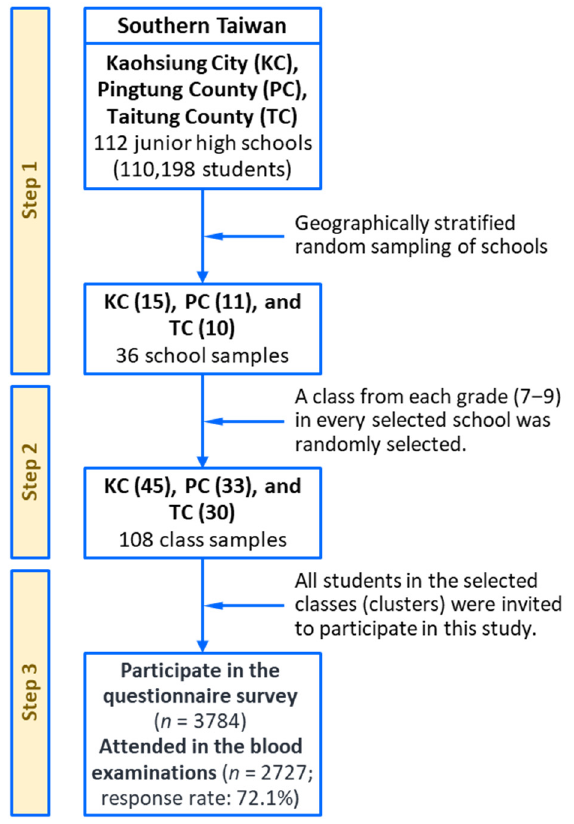
Figure 1. A multistage, geographically stratified cluster-sampling scheme for the southern Taiwan multilevel study.